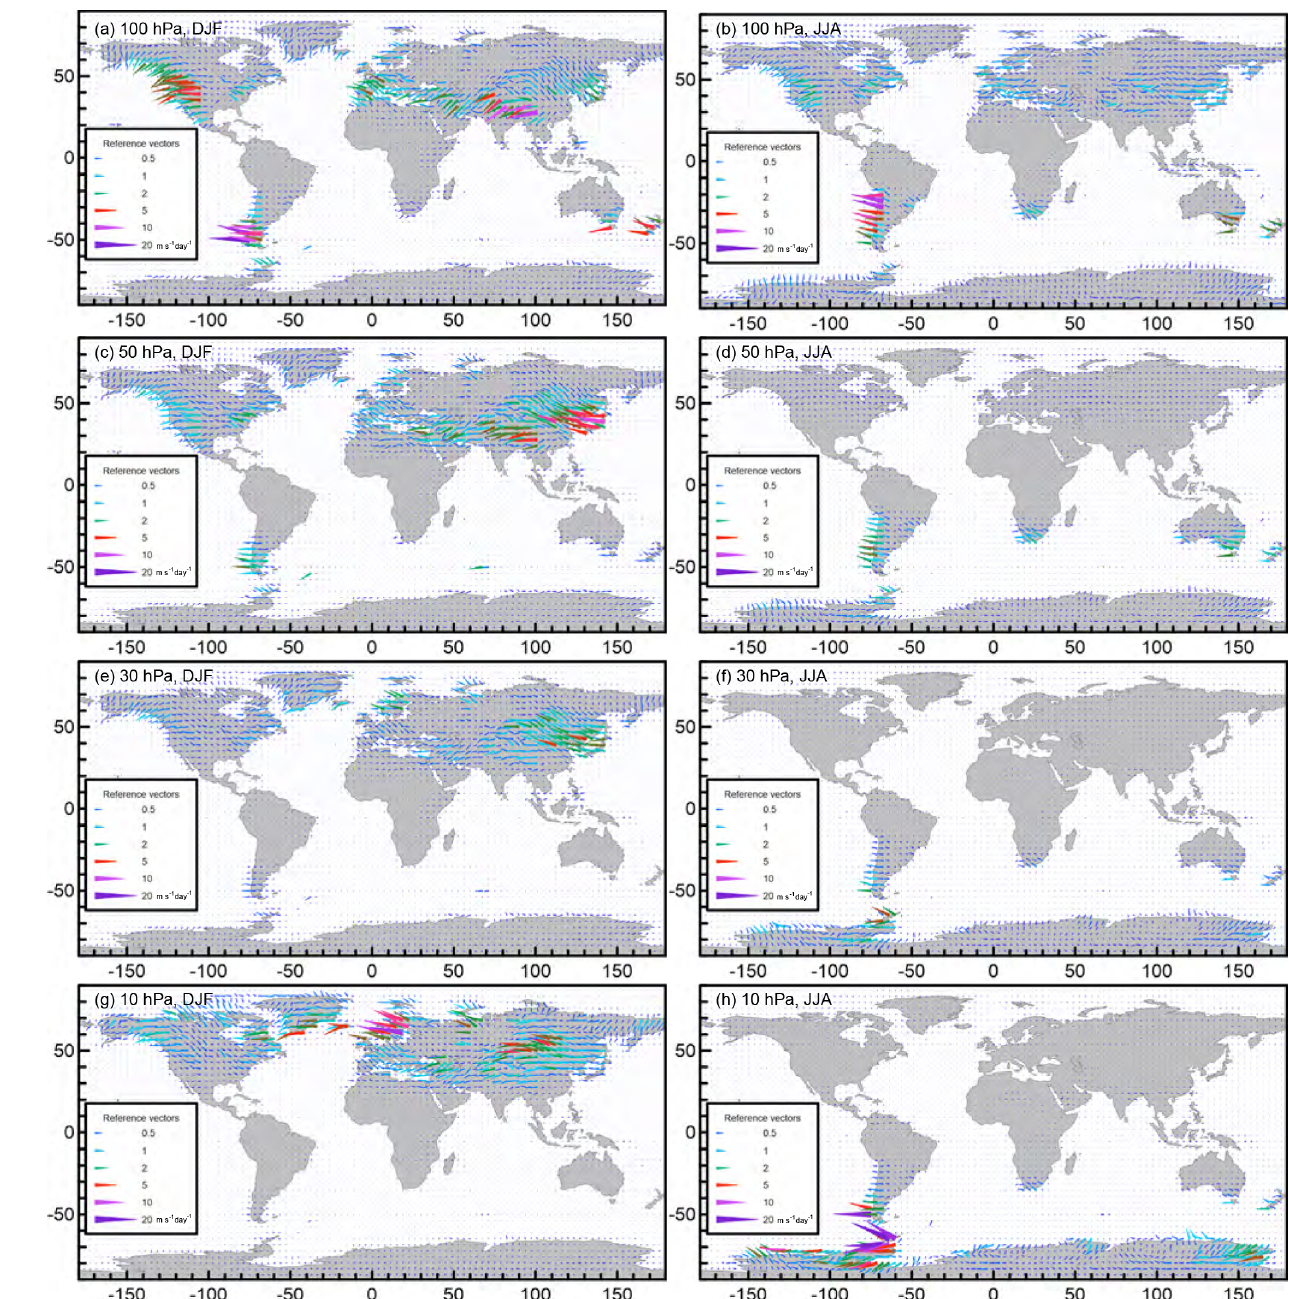
Figure 1. Mean seasonal wind tendency due to OGWs (ms − 1 day − 1 ) at the 100hPa (a, b) , 50hPa (c, d) , 30hPa (e, f) and 10hPa (g, h) level, during DJF (a, c, e, g) and JJA (b, d, f, h)